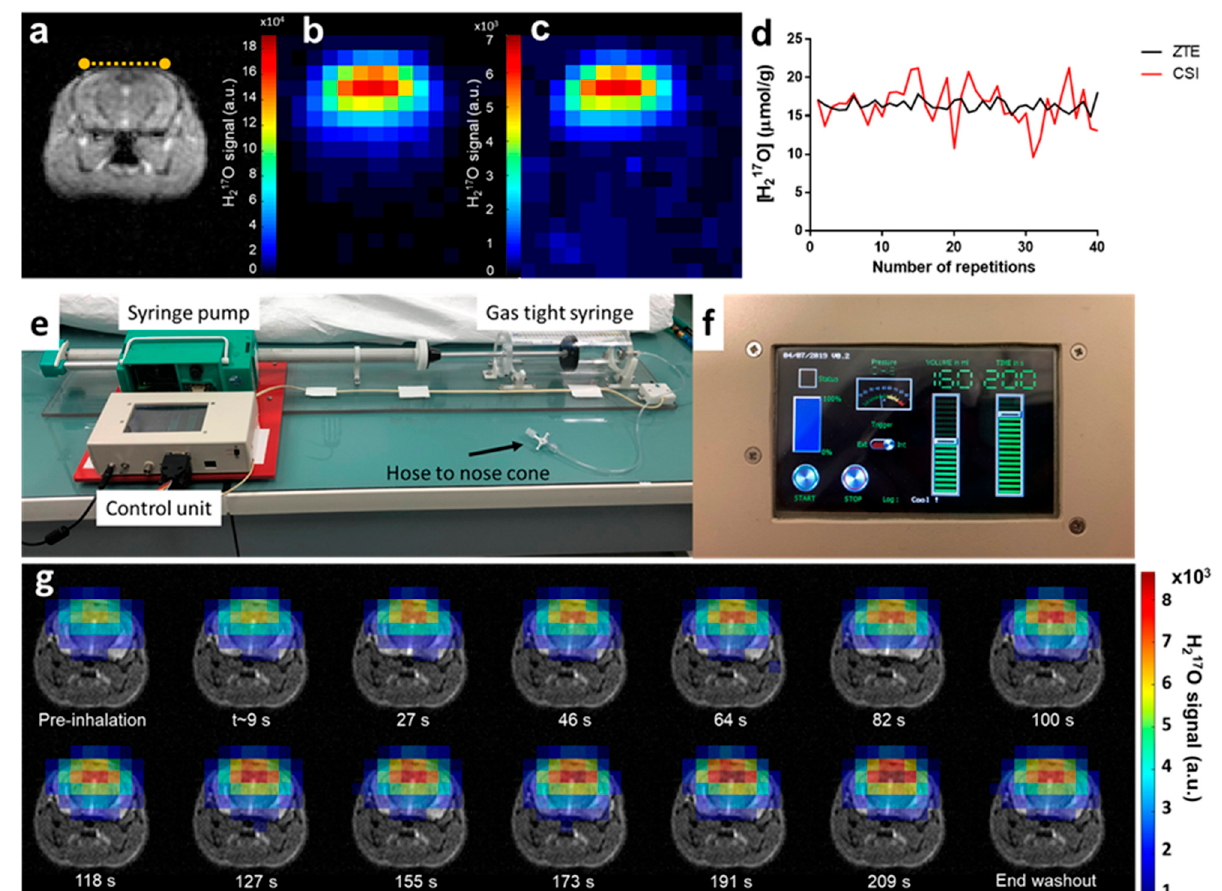
Figure 1. Experimental set-up and in vivo acquisitions. ( a ) Coronal T2 weighted image of a wild-type mouse brain. The yellow dotted line indicates the 17 O surface coil position on top of the head of the animal. In vivo natural abundance H 217 O images acquired with ( b ) zero echo time (ZTE) and ( c ) chemical shift imaging (CSI) sequences, respectively, demonstrating higher signal-to-noise ratio (SNR) for ZTE. Both images are scaled relative to their respective maximum value. ( d ) Single voxel signal normalized to brain water 17 O natural abundance displayed over 40 repetitions, showing lower temporal variability for ZTE (black curve) than for CSI (red). ( e ) The 17 O 2 delivery system consists of a gas-tight acrylic syringe (500 mL, Hamilton) and a customized syringe pump. The stepper motor is driven by a microcontroller unit (Arduino, Uno R3) and was programmed to allow both manual and MR sequence-triggered activation of the syringe. ( f ) The control unit programmable tactile graphic user interface (4D system, μ LCD-43PT) allows prescribing the inhalation protocol parameters (volume, duration and start/stop control). ( g ) The time-course of H 217 O-ZTE images acquired on our Bruker 11.7 T scanner before, during, and after 17 O inhalation co-registered with the corresponding anatomical image shows incorporation of labeled oxygen in water signal until the end of the inhalation period. Signal decays thereafter and reaches a new steady state, 15 min after the end of the inhalation (end washout).